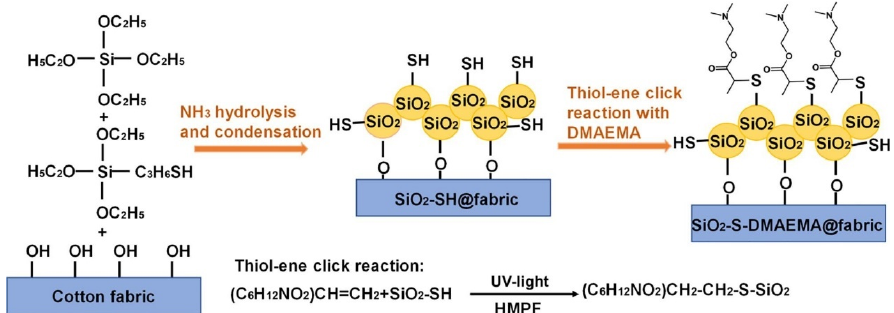
Figure 12. Schematic illustration of the formation of SiO 2 -S-DMAEMA on cotton fabric (Reproduced from [135], with kind permission of Elsevier).